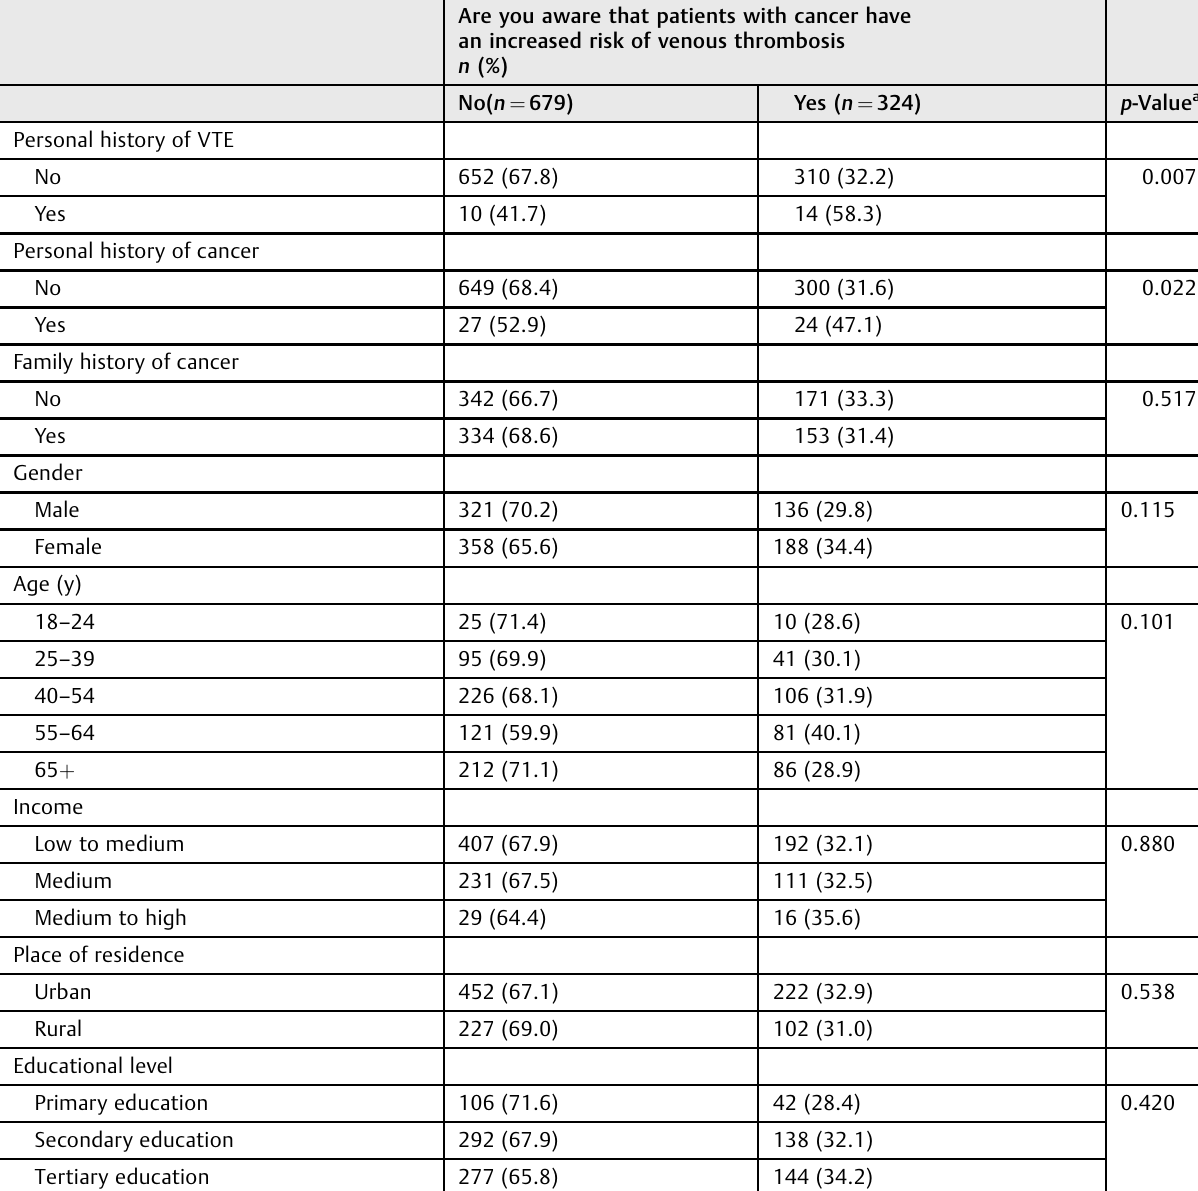
Table 3 Number and percentage of respondents reporting awareness of the association between cancer and VTE by respondent characteristics ( n ¼ 1,003)